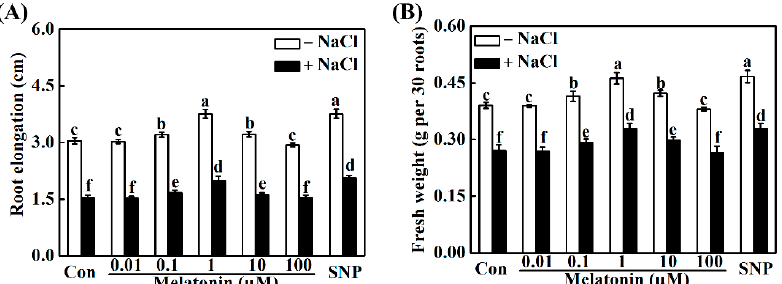
Figure 3. NaCl stress-triggered growth inhibition of seedling roots was alleviated by exogenous melatonin and sodium nitroprusside (SNP; a NO-releasing compound). Three-day-old rapeseed seedlings were pretreated with the indicated concentrations of melatonin or 10 µ M SNP for 12 h, and then transferred to 200 mM NaCl for another 2 days. Afterwards, the root elongation ( A ) and root fresh weight ( B ) were measured. The sample without chemicals was the control (Con). Values are means ± SE of three independent experiments, with at least three replicates for each. Bars with different letters are significant different at p < 0.05 according to Duncan’s multiple range